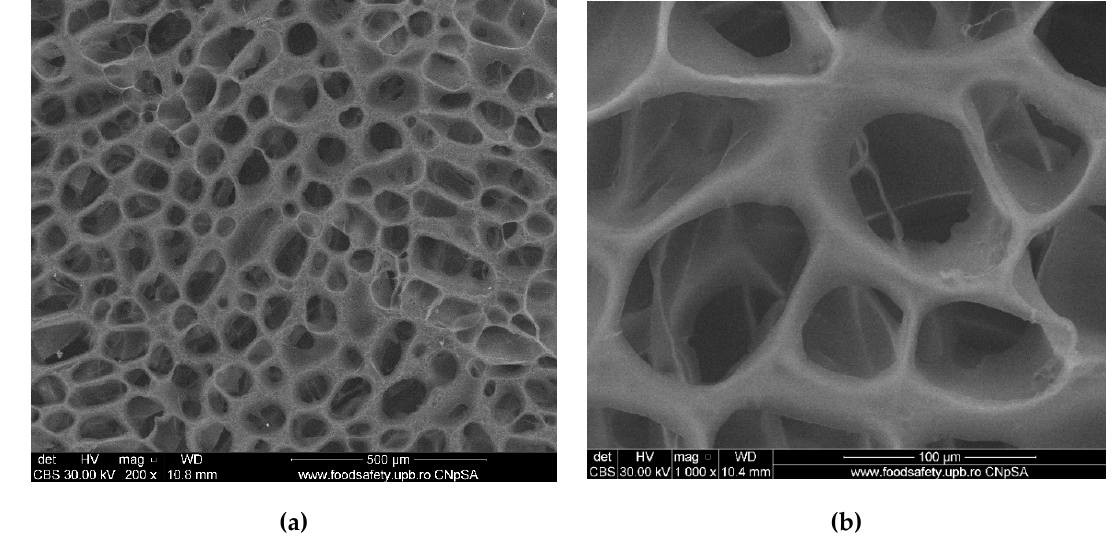
Figure 6. SEM micrographs ( a -general aspect, b -an up-close detail) of freeze-dried chitosan sample (CS).